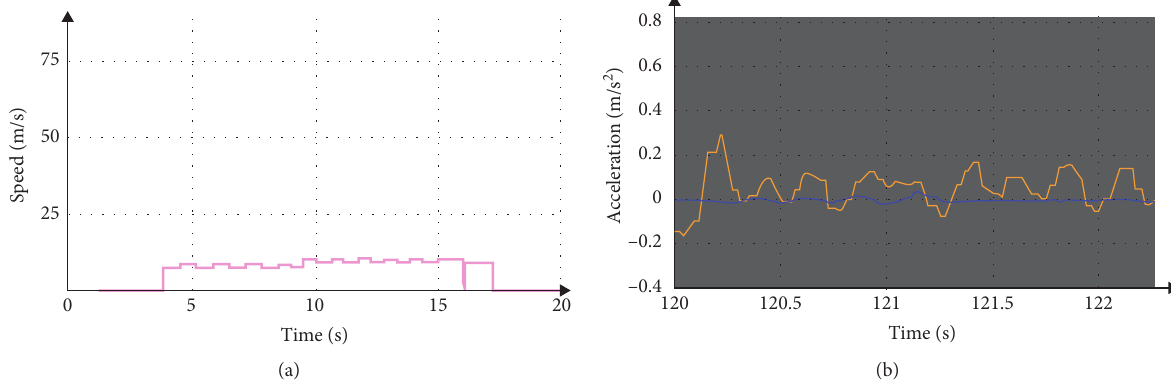
Figure 2: Signal acquisition software interface. (a) Speed signal acquisition. (b) Acceleration signal acquisition.